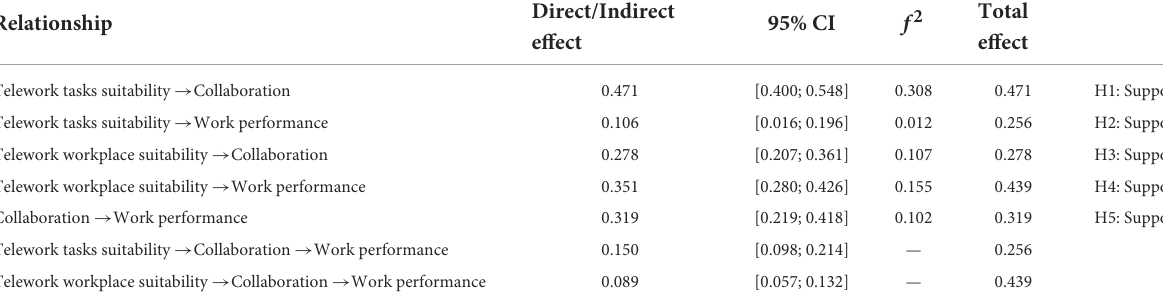
Direct/Indirect effect effect